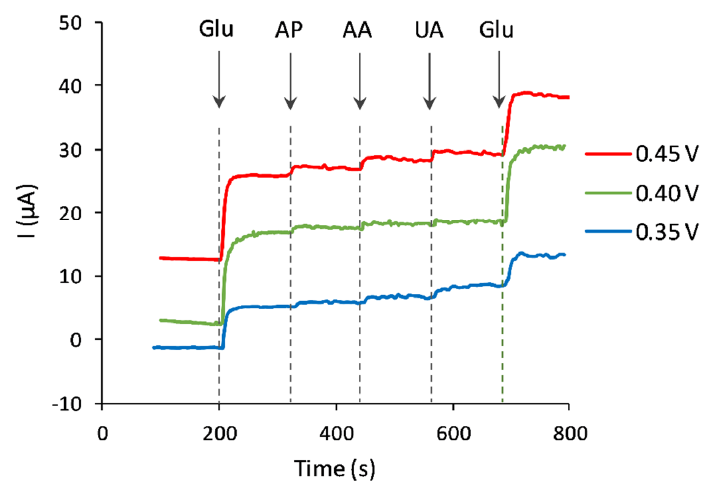
Figure 6. Amperometric responses of the Au-MPTS-Pt to successive additions of 1 mM glucose, 0.1 mM AP, 0.1 mM AA, 0.1 mM UA and 1 mM glucose, respectively, in 0.1 M PBS (pH 7.4) at applied potentials of 0.35 V (blue), 0.40 V (green) and 0.45 V (red).